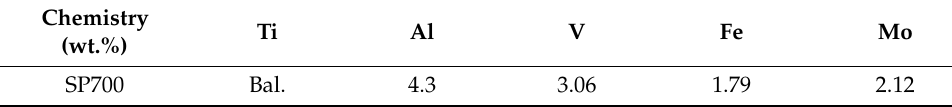
Table 1. Chemical compositions of the SP700 alloy.